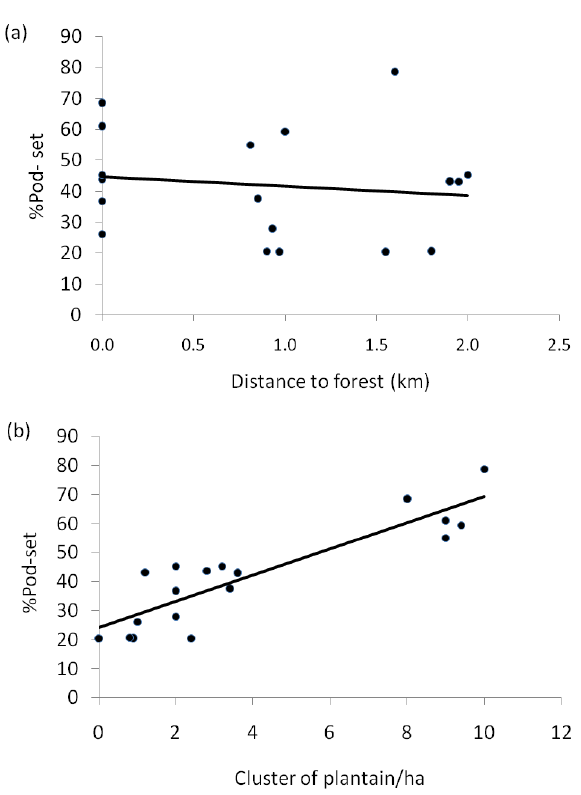
F IG . 2. Relationship between cocoa pod-set: (a) Distance of farm from forest: y = 44.52 - 0.03 x2, r2 = 0.02, n = 18, f = 0.38, p = 0.544. (b) Cluster of plantain/banana in or near cocoa farm: